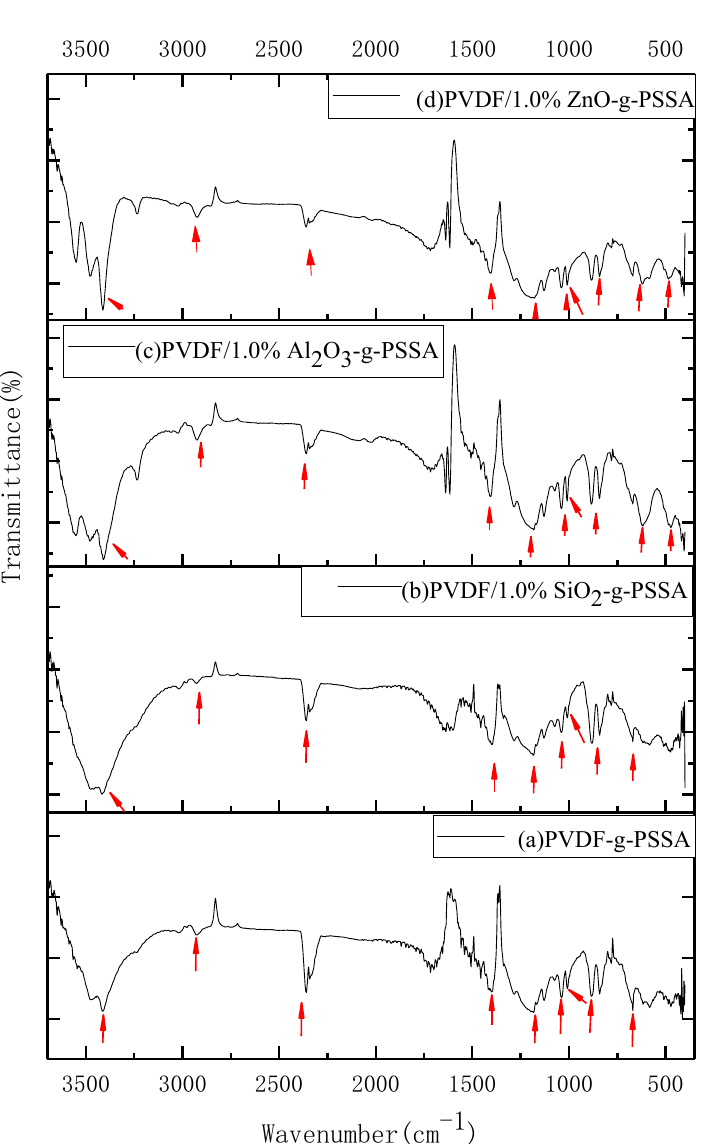
Figure 6. FTIR spectra of the prepared membranes (with the weight fraction 1.0% of inorganic nanoparticles taken as an example).